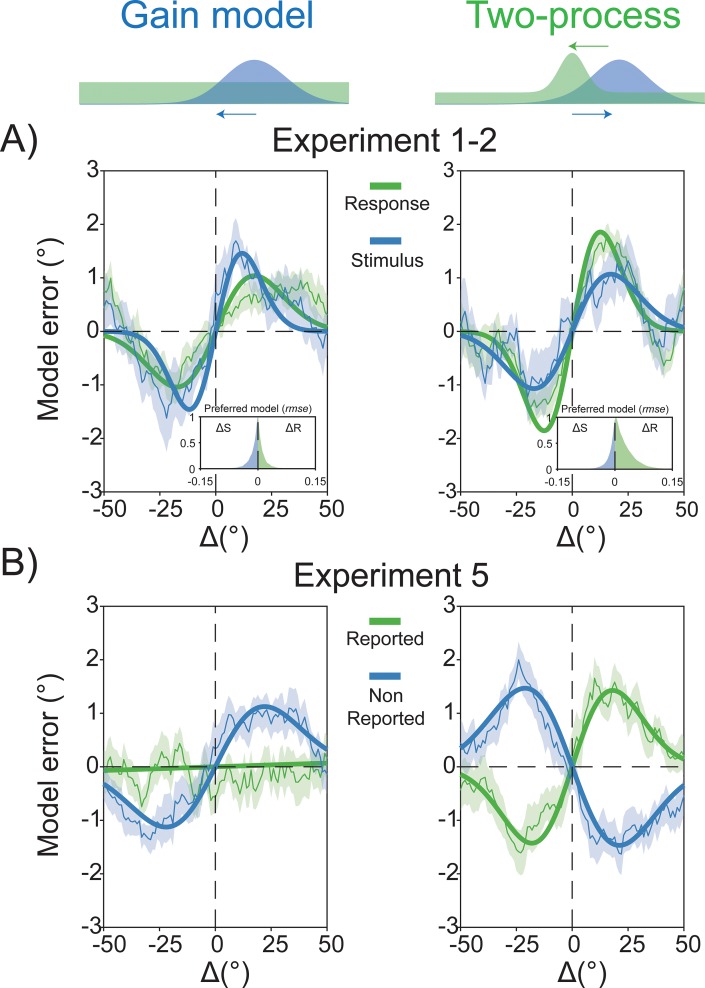
Predictions of the two data-generating models.(A) Compared to the Gain model (left plot), the Two-process model (right plot) better approximated the general pattern of results observed in Experiments 1 and 2, reproducing the observed improvement in model fit when considering ΔR instead of ΔS (inset plots of rmse). (B) Predictions of the two models in the context of Experiment 5. The Gain model (left plot) showed consistent dependencies on the last nonreported stimulus in the sequence, with no persisting effect of the orientation reported in the past. The Two-process model (right plot) revealed the opposite effect of repulsive adaptation for nonreported stimuli and attractive serial dependence for the perceptual decision and related stimulus one trial in the past. ΔR, delta response; ΔS, delta stimulus; rmse, root-mean-square error.